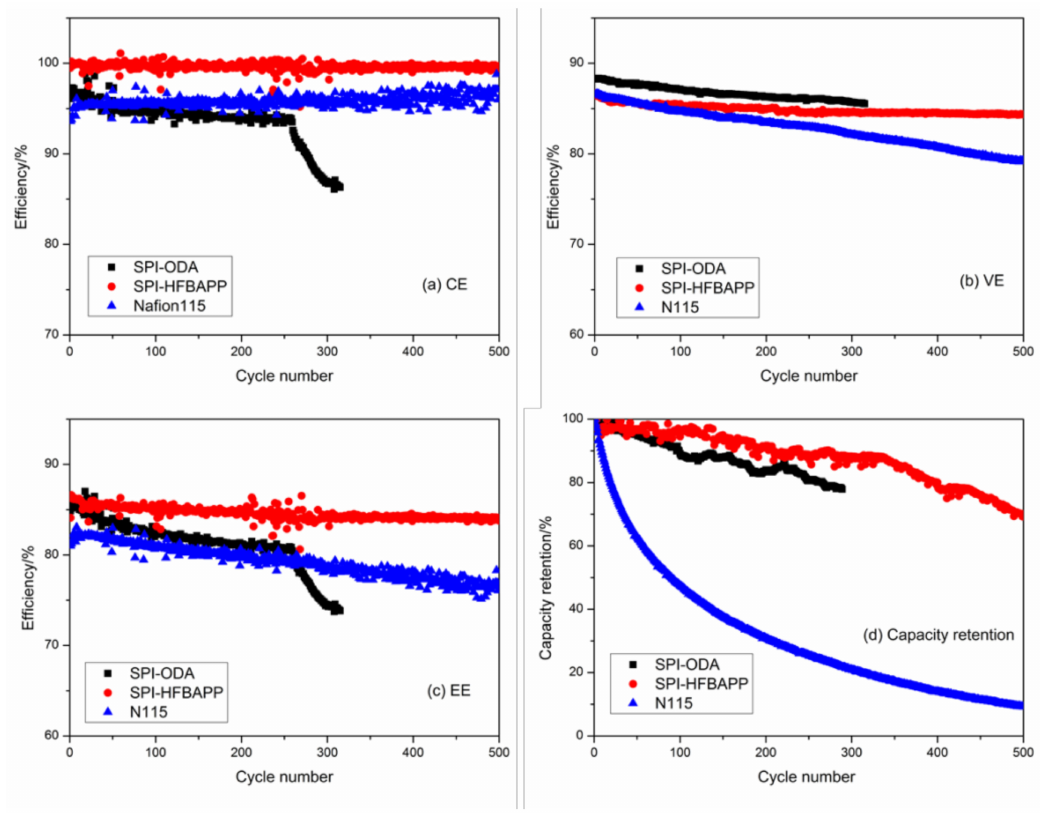
Figure 5. Cycling stability of the VRFB with SPI membranes and N115 at current density of 100 mA · cm − 2 . ( a ) CE; ( b ) VE; ( c ) EE; ( d ) Capacity retention.